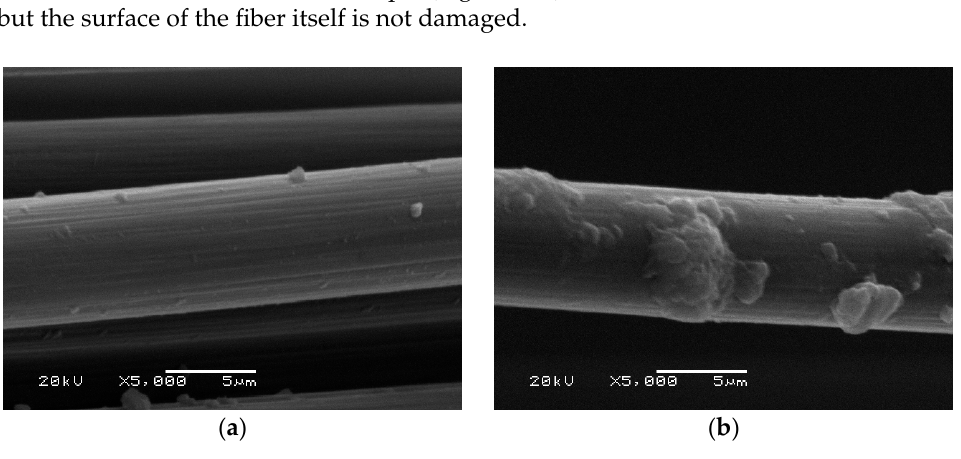
Figure 14. SEM image: Carbon fiber ( a ) as delivered; ( b ) derived from a sample based on a fly ash matrix.